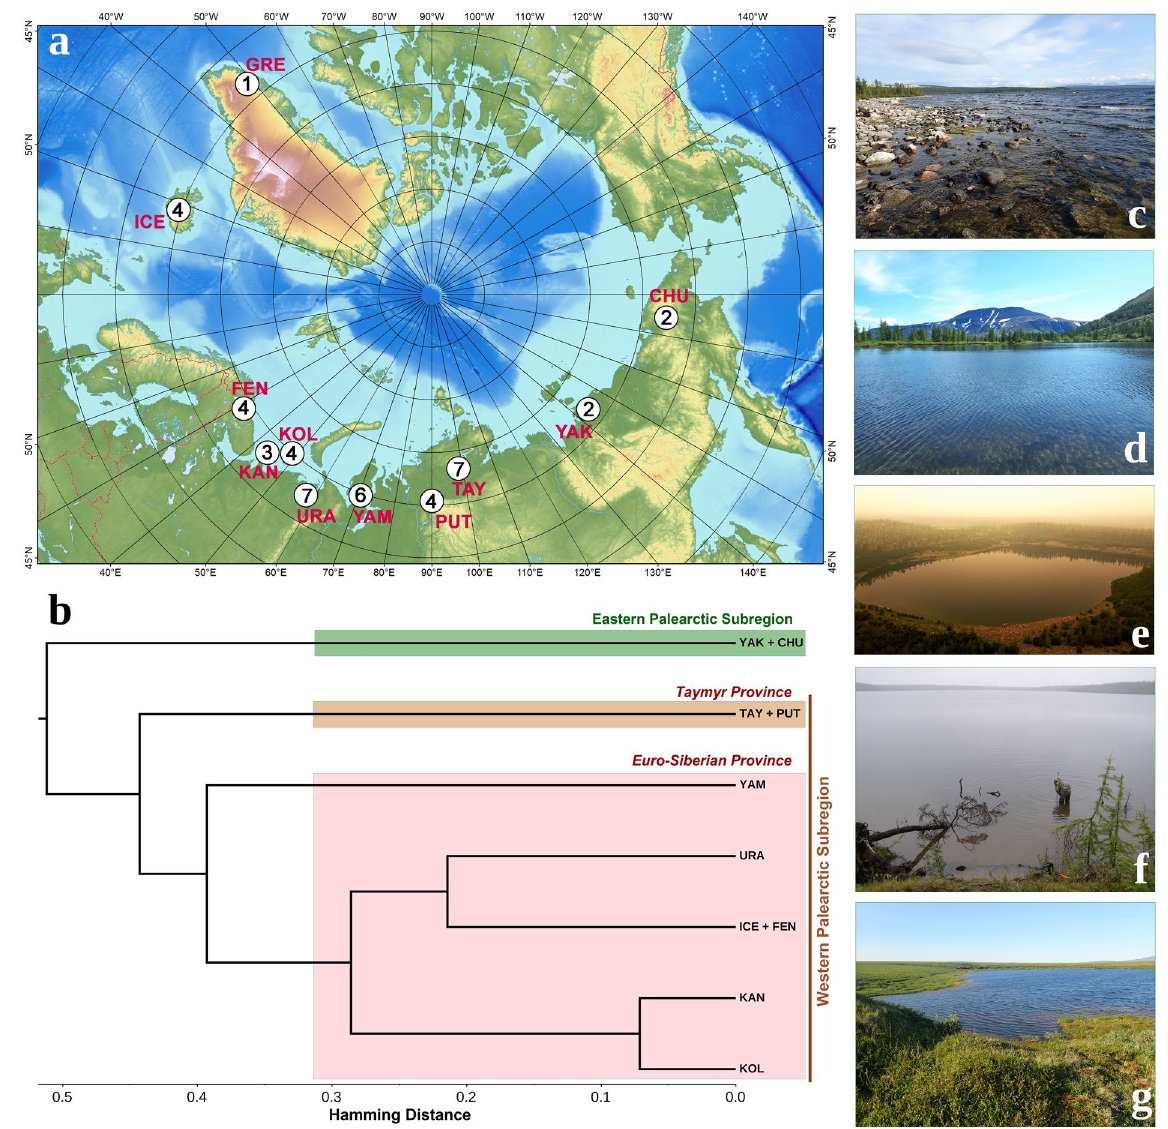
Figure 2. Species richness, biogeography, and habitats of freshwater leeches (Glossiphoniidae) in the Eurasian Arctic. The subregion’s codes are as follows: Iceland (ICE); Fennoscandia: Arctic Scandinavia and Kola Peninsula (FEN); Kanin Peninsula and Malozemelskaya Tundra (KAN); Kolguev Island (KOL); Bolshezemelskaya Tundra (eastern part) and Polar Urals (URA); Yamal Peninsula (YAM); Taymyr Peninsula (TAY); Putorana Plateau (PUT); Arctic Yakutia (YAK); and Chukotka Peninsula (CHU). ( a ) Map of species richness. The open circles indicate the Arctic subregions; the numbers in circles indicate the species richness of freshwater leeches in a given subregion (see Table 2 for the presence-absence data). The map was created using ESRI ArcGIS 10 software (www. esri. com/ arcgis). ( b ) Dendrogram of cluster analysis (UPGMA) based on the presence-absence dataset of glossiphoniid leeches throughout subregions of the Eurasian Arctic: pink , Europe, the Urals, and Western Siberia; brown , Eastern Siberia; and green , Far East. The raw distribution data is presented in Table 2 and Supplementary Dataset S3. ( c ) Lake Imandra on Kola Peninsula, habitat of Glossiphonia balcanica . ( d ) A lake near Sob’ railway station, Polar Urals, habitat of G. arctica sp. nov. (the type locality), G. balcanica ,